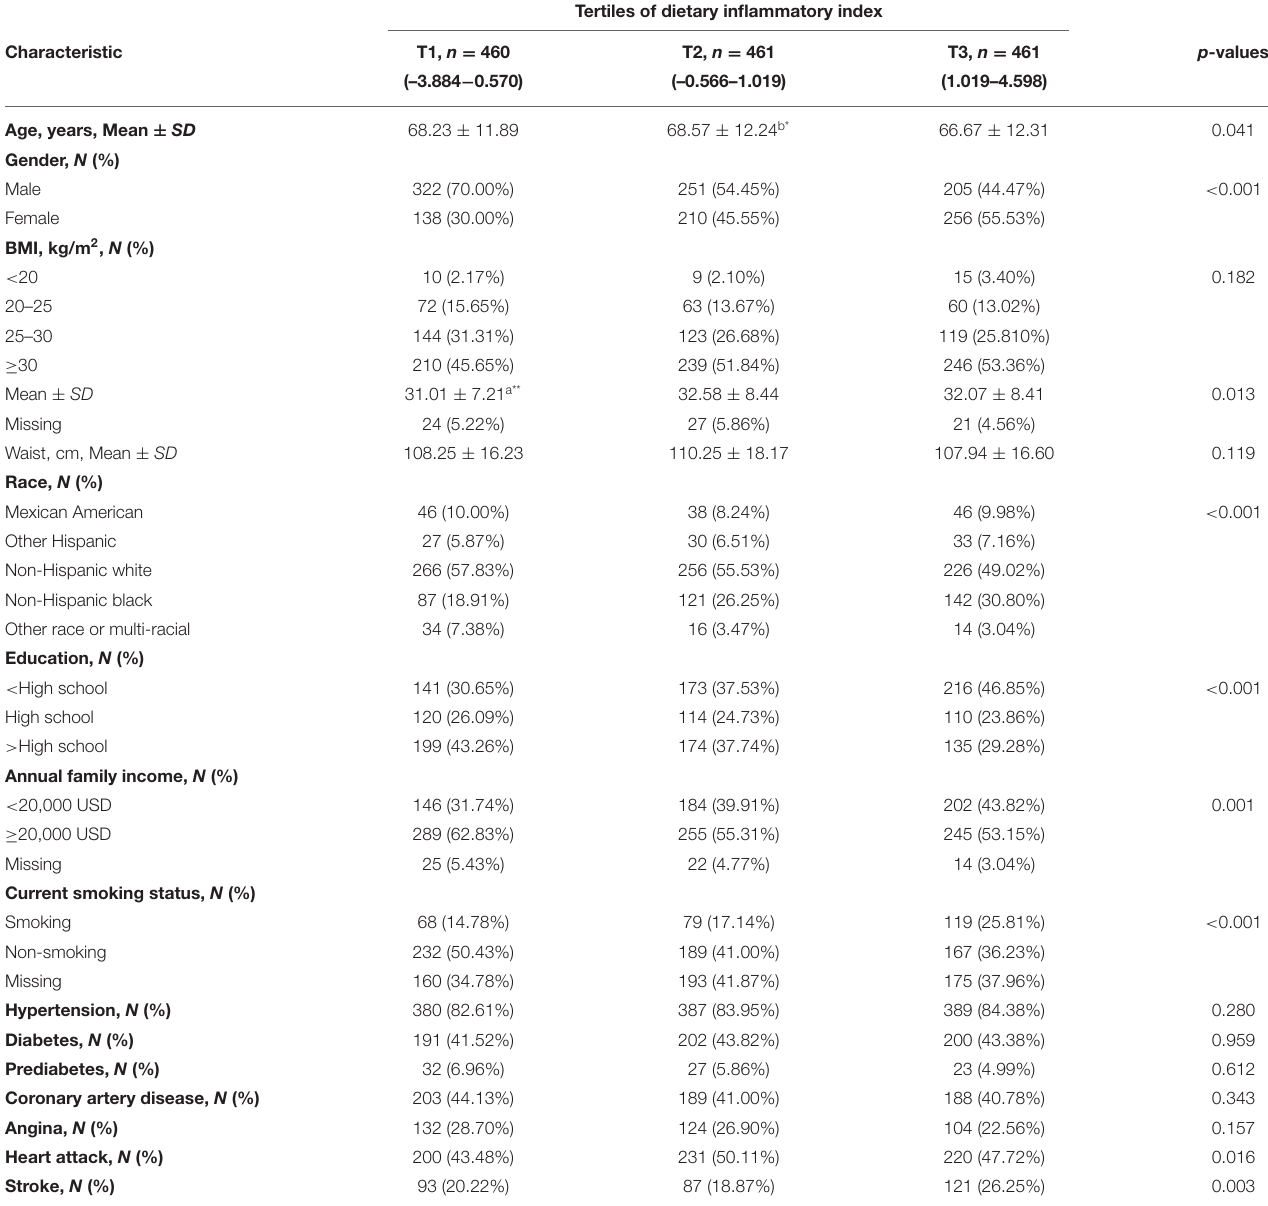
Tertiles of dietary inflammatory